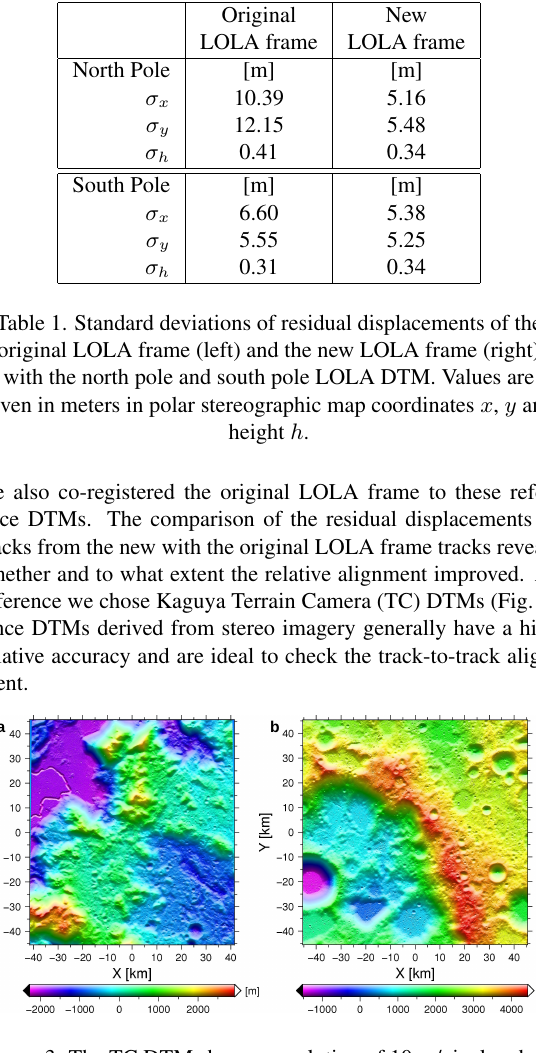
Figure 3. The TC DTMs have a resolution of 10 m/pixel and are shown in local stereographic projection. (a) Near side: DTM is centered at 4.5 ◦ longitude and 25.5 ◦ latitude with the Apollo 15 landing site in the upper left corner. (b) Far side: DTM is centered at 181.5 ◦ longitude and -1.5 ◦